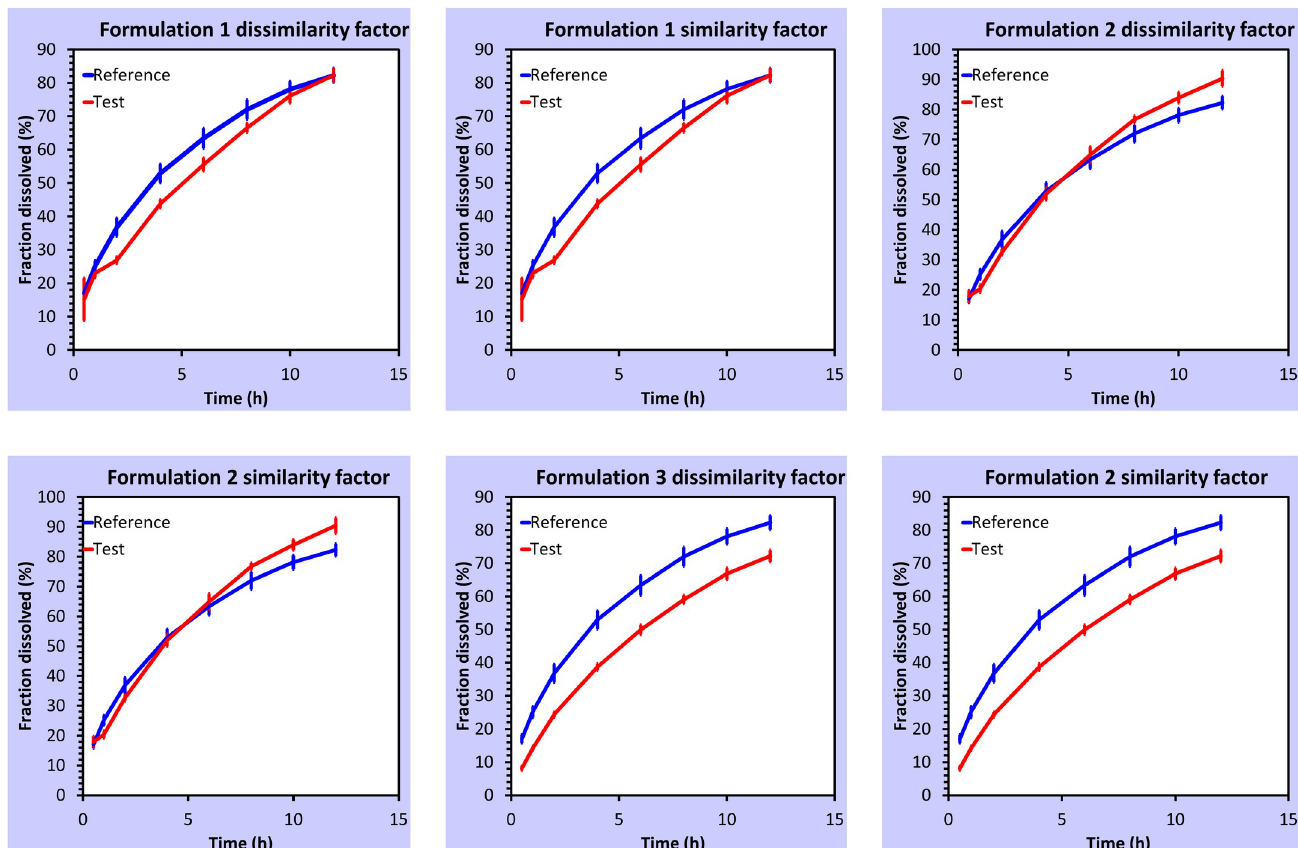
Fig 4. Graphical representation of a pairwise comparison of f1 and f2 factors of propranolol HCl formulations using F4 formulation as reference.